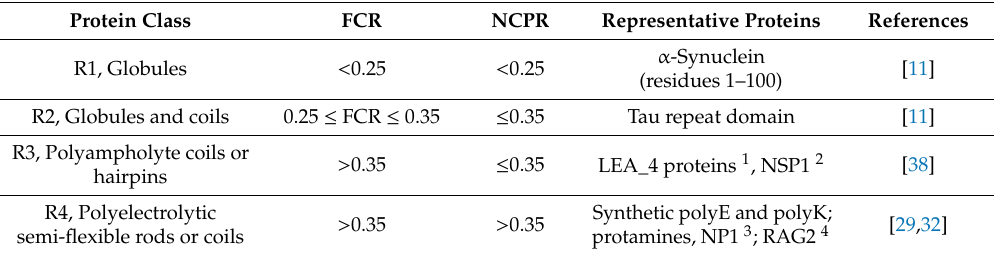
Table 1. Examples of intrinsically disordered proteins (IDPs) and protein regions (IDRs) belonging to the distinct regions of the Das-Pappu’s conformational phase